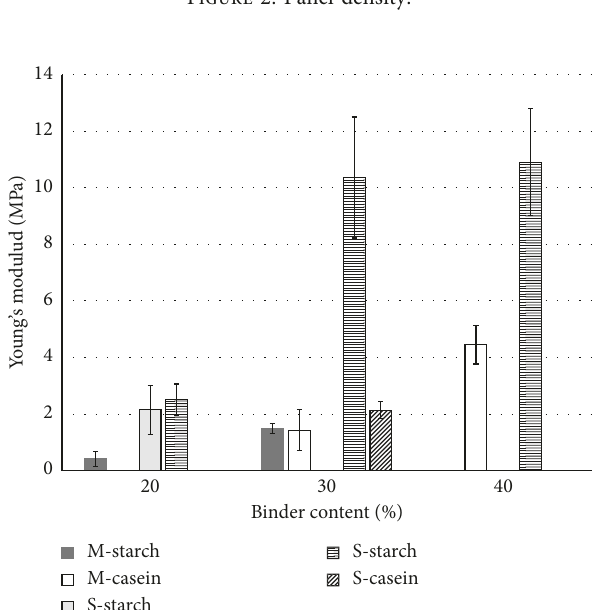
Figure 2: Panel density.